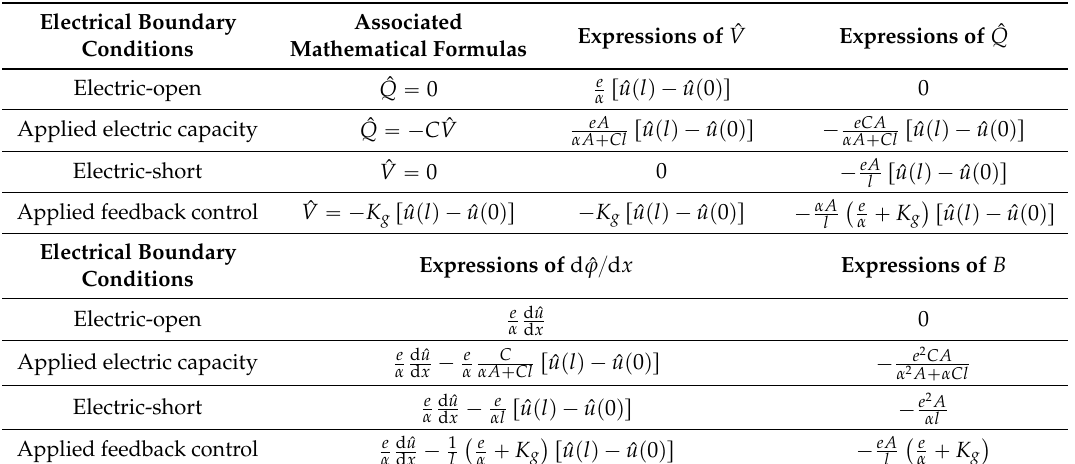
Table 1. The expressions of involved electrical variables as formulas of mechanical